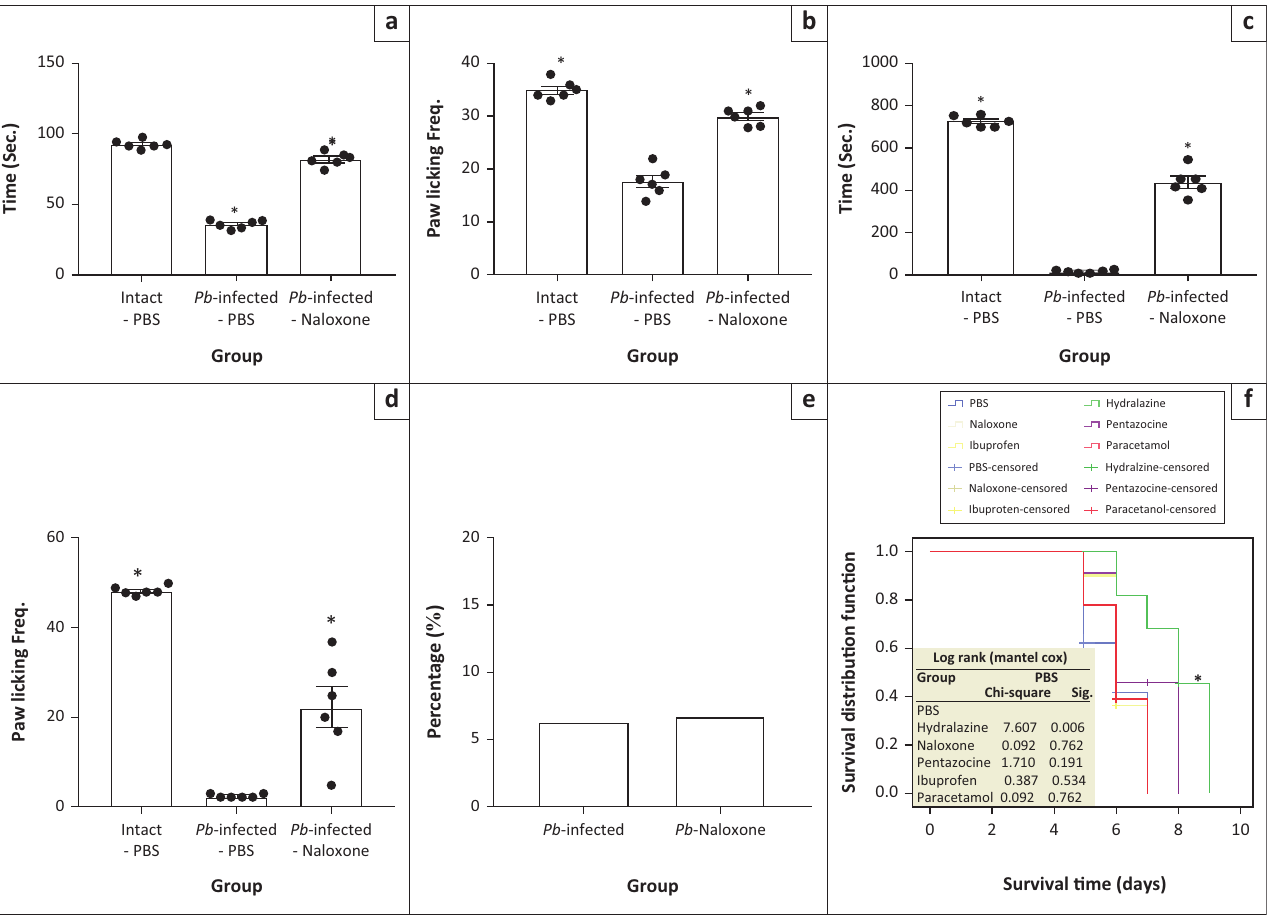
FIGURE 7: Impact of naloxone on pain sensitivity and survival time in Pb - infected mice. (a) and (b) Time used for paw licking and its frequency during the early phase (0–5 min) of formalin test, respectively. (c) and (d) Time spent on paw licking and its frequency during the late phase (20–50 min) of formalin test. (e) Percentage parasitaemia level. (f) Survival time in Pb -infected